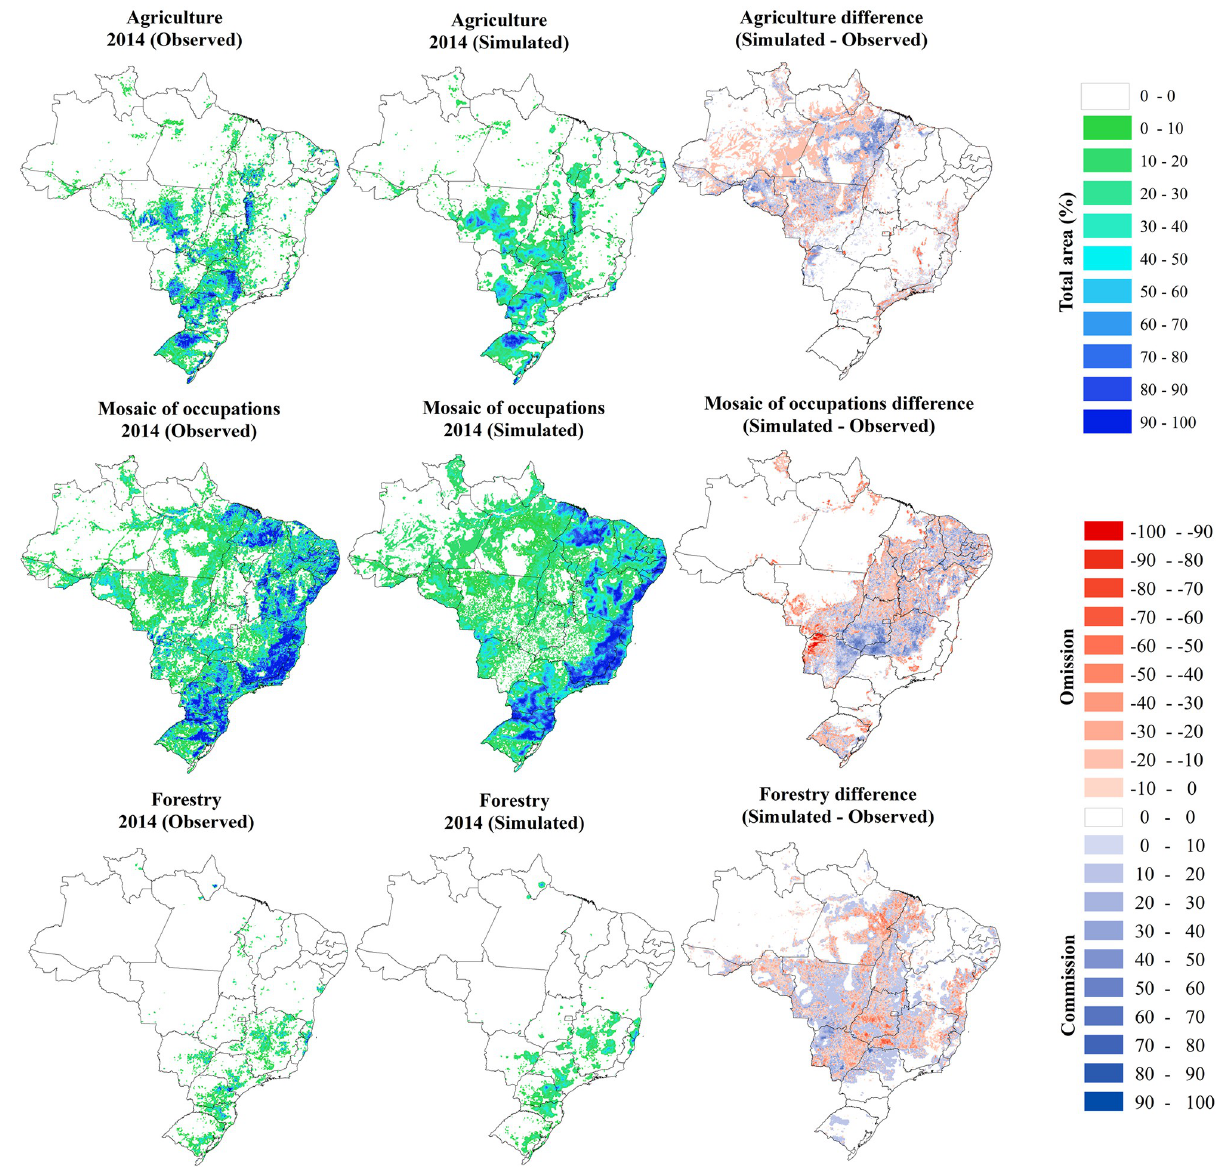
Fig 5. Percentage of Agriculture, Mosaic of occupation and Forestry observed versus simulated in 10 x 10 km 2 cells in 2014 and the spatial distribution of errors of omission and commission. The source of States boundaries is according to IBGE [31].